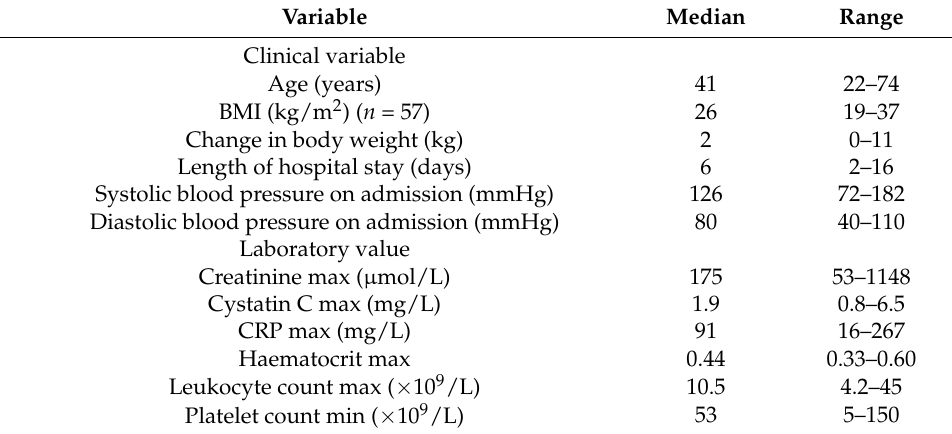
Table 1. Clinical and laboratory characteristics of 66 patients with acute PUUV infection. Variable Median